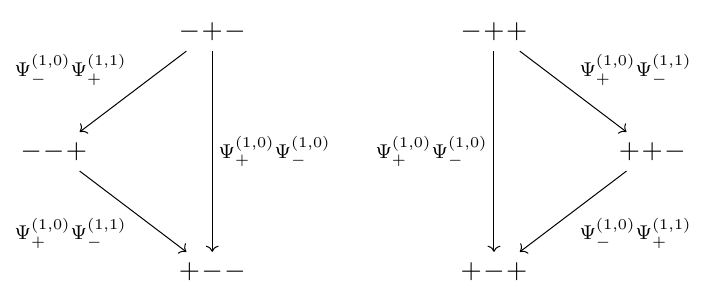
Figure 2 . The RG flows triggered by relevant boundary deformations in the /∂ 3 ψ